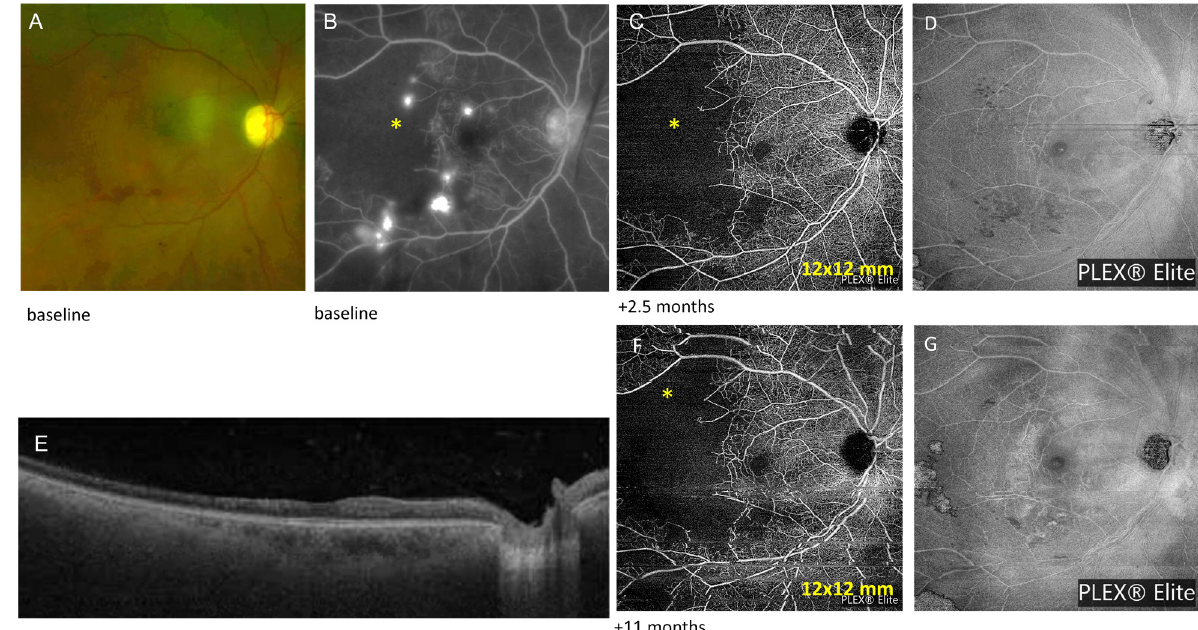
Figure 1. Case 1: Ischemic retina in lupus retinopathy. ( A ) Fundus photo showing ischemic maculopathy with telangiectatic vessels (abnormal prominent capillaries) at its border in the right eye; ( B ) Fluorescein angiography (intermediate phase) showing a macular area of capillary non-perfusion (asterisk) and hyperfluorescent telangiectatic vessels at its border; ( C ) Zeiss PLEX ® Elite 9000 OCTA (12 mm × 12 mm) demonstrating an area of “flow deficit” or decreased signal in the superficial capillary plexus (SCP) corresponding to retinal ischemia in the temporal area (asterisk); ( D ) The border of nonperfusion is seen on the structural OCT; ( E ) SD-OCT showing foveal thinning; ( F ) Eleven-month follow-up OCTA that shows no change in flow deficit; ( G ) The border of nonperfusion is seen on the corresponding structural OCT